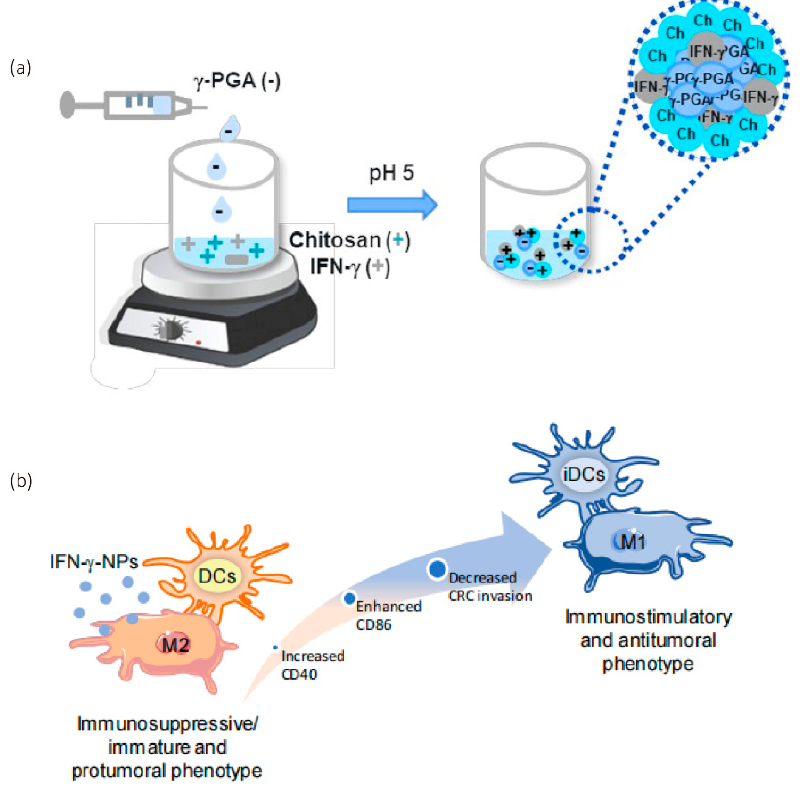
Figure 1. ( a ) Schematic representation of IFN- γ -NPs production and ( b ) the potential synergistic effect of chitosan/y-PGA nanoparticles with immunomodulatory cytokines, such as IFN- γ , for anti- cancer therapy. Reproduced with permission from Castro, F. et al., Biomaterials Science ; published by the Royal Society of Chemistry, 2019 [25] .